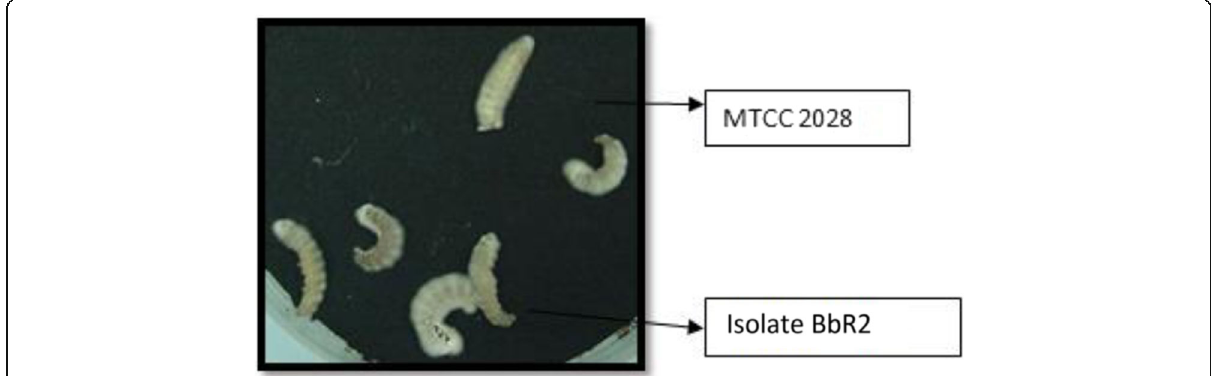
Fig. 1 Galleria mellonella larvae showing infection with two different fungal isolates establishing their entomopathogenic characteristics. Galleria mellonella larvae infected with fungal isolate BbR2 and Beauveria bassiana MTCC